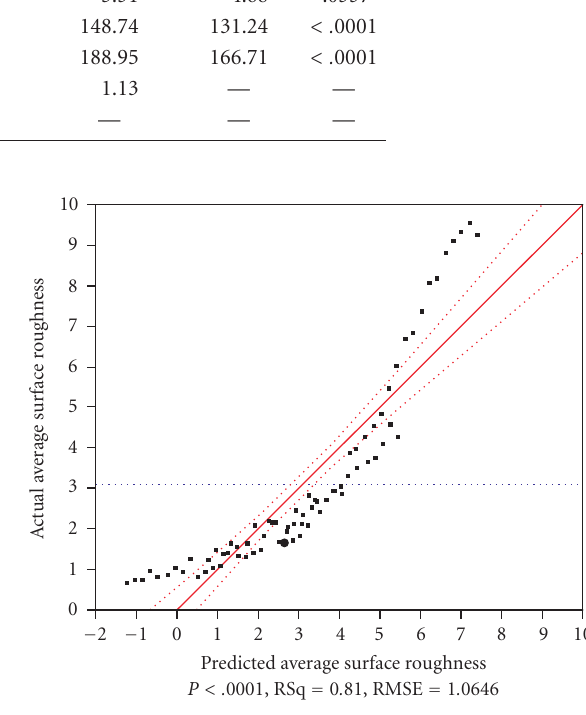
Figure 5: The actual surface roughness versus predicted surface roughness of main e ff ects model.